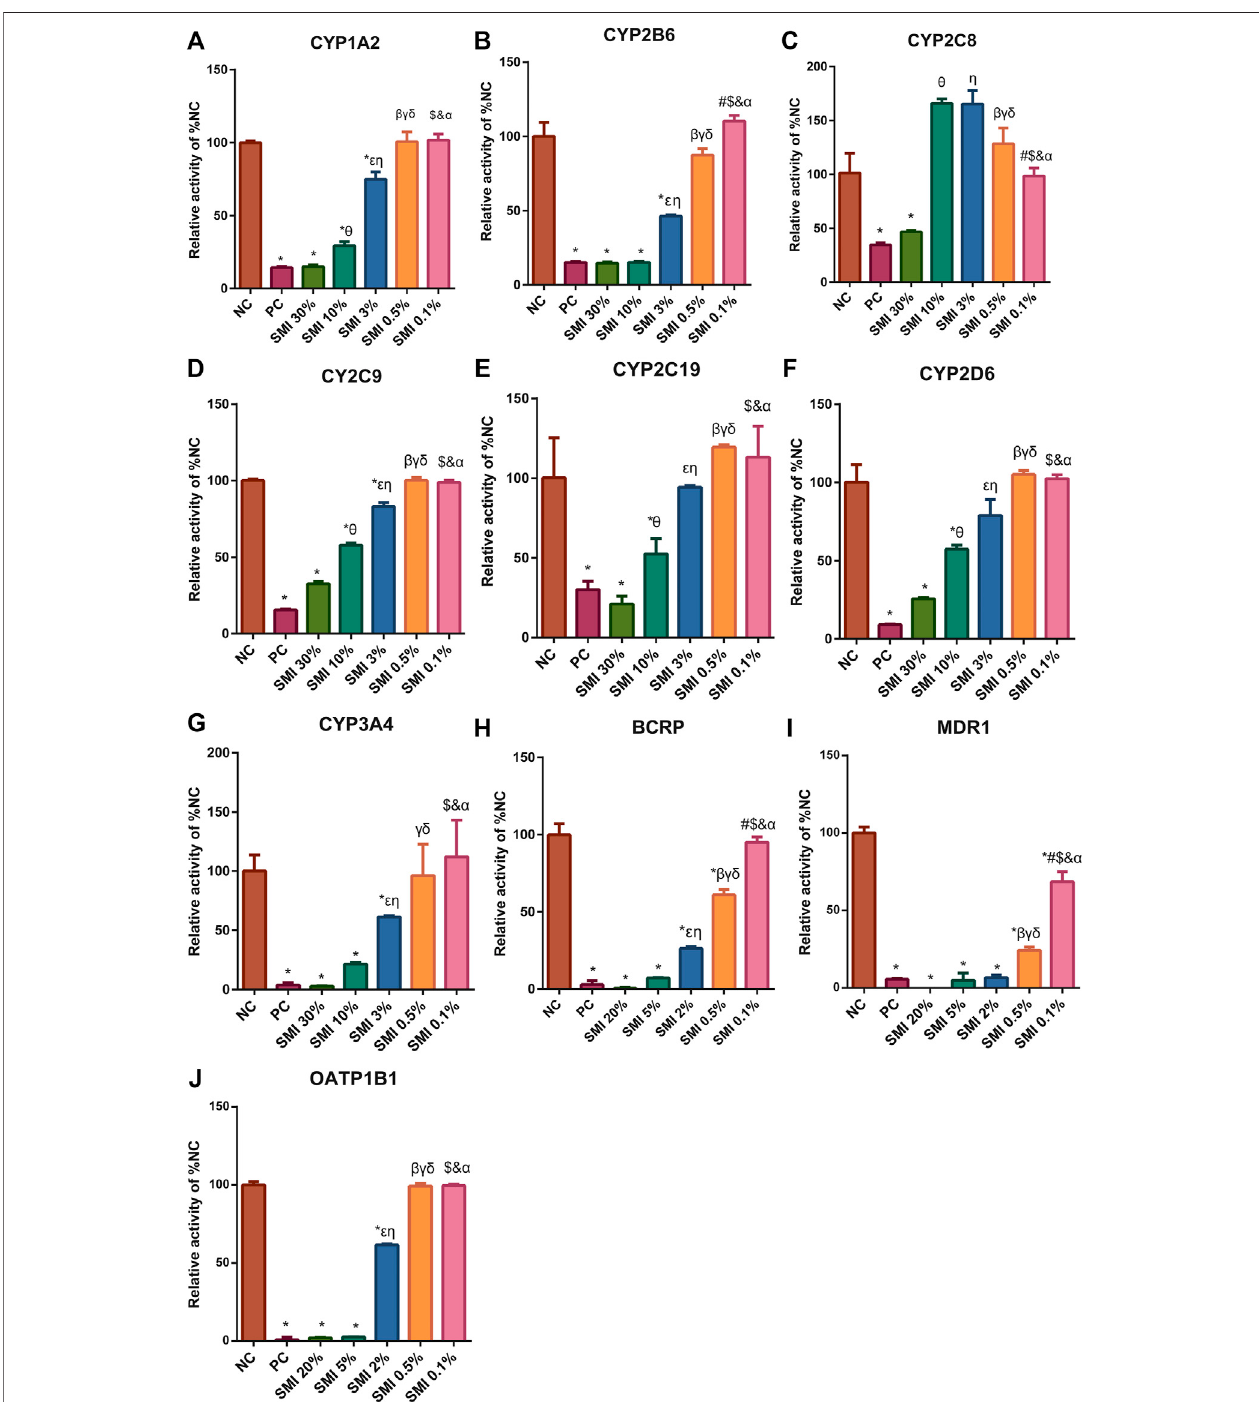
FIGURE 4 | After different concentrations of SMI treatment, the CYP450 enzyme (A – G) and drug transporters (H – J) activities were shown. * indicates p < 0.05 comparedwithNCgroup.ComparisonofenzymeactivitiesafterdifferentconcentrationsofSMItreatment,in fi gure (A – G) ,0.1% vs .0.5%,# p < 0.05;0.1% vs .3%,$ p < 0.05; 0.1% vs . 10%, & p < 0.05; 0.1% vs . 30%, α p < 0.05; 0.5 vs . 3%, β p < 0.05; 0.5 vs . 10%, γ p < 0.05; 0.5 vs . 30%. δ p < 0.05; 3 vs . 10%, ε p < 0.05; 3 – 30%, η p < 0.05; 10 – 30%, θ p < 0.05. In fi gure (H – J) , 0.1 vs . 0.5%, # p < 0.05; 0.1 vs . 2%, $ p < 0.05; 0.1 vs . 5%, & p < 0.05; 0.1 vs . 20%, α P < 0.05; 0.5 vs . 2%, β P < 0.05; 0.5 vs . 5%, γ P < 0.05; 0.5 vs . 20%, δ P < 0.05; 2 vs . 5%, ε P < 0.05; 2 vs . 20%, η P < 0.05; 5 vs . 20%, θ P < 0.05. NC, negative control group; PC, positive control group.